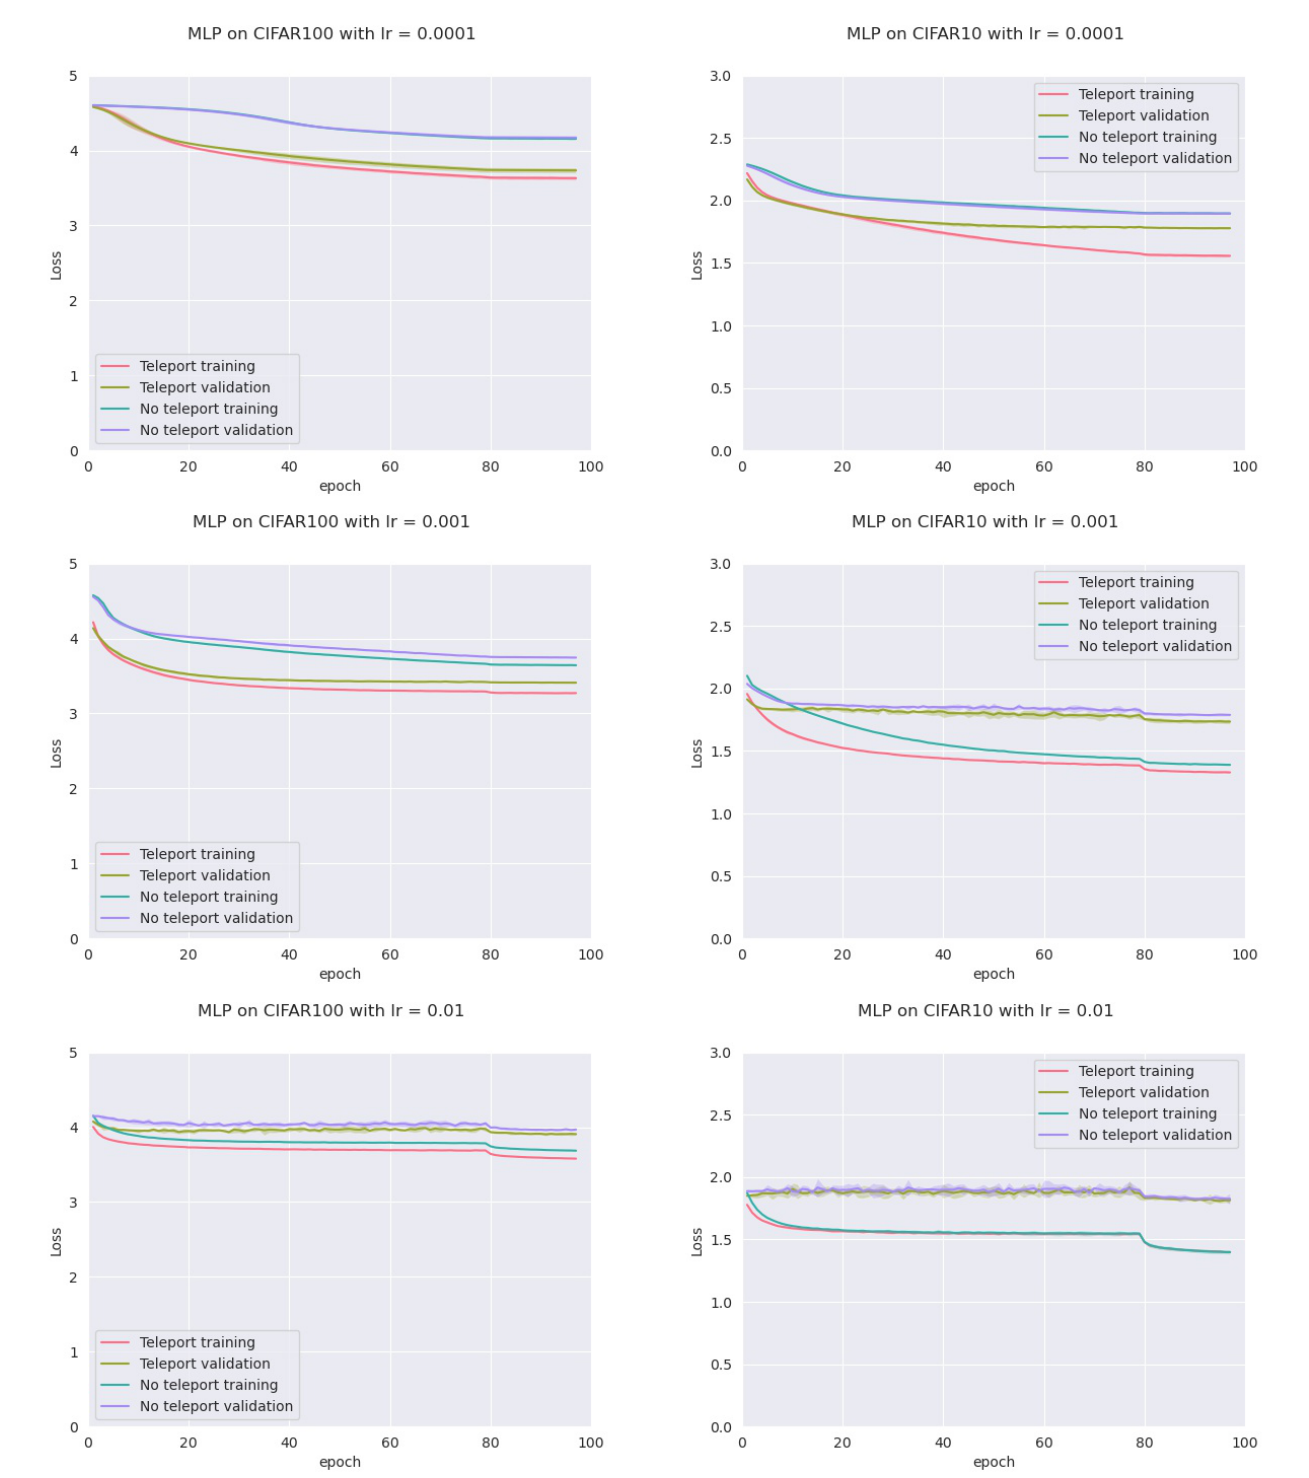
Figure A9. Average loss of MLPs with ELU activation function on CIFAR100 ( left ) and Tanh on CIFAR10 ( right ) over 5 experiments for each, with and without teleportation at the beginning of the training with CoB of 0.9. Learning rate increases from top to bottom rows. We also show a shadow around the average curves at two times the standard deviation over the five